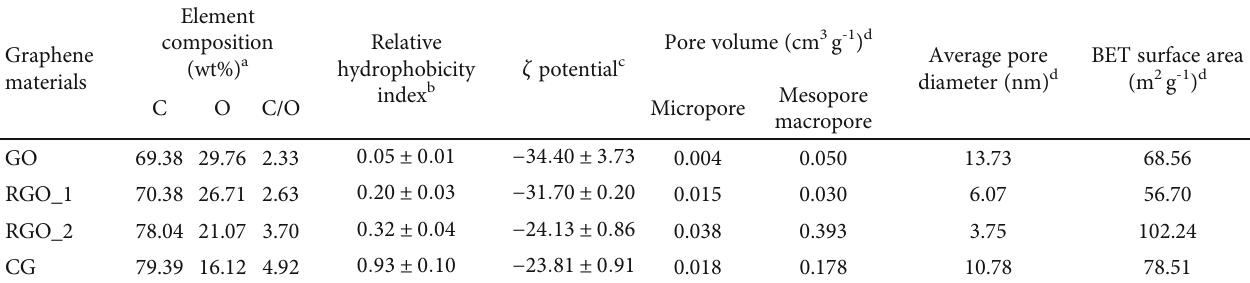
Table 1: Selected physicochemical properties of GO, RGO_1, RGO_2, and CG.